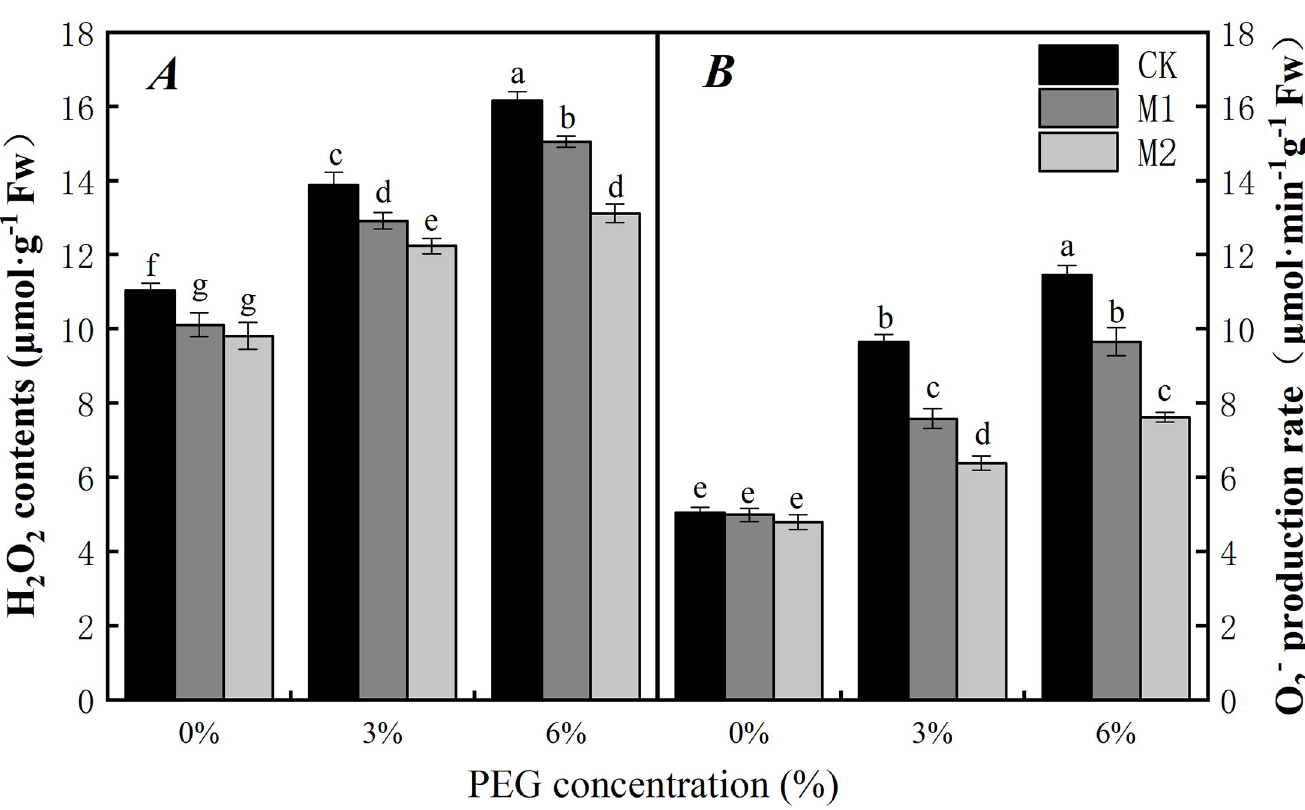
Fig 2. Effect of soaking with melatonin on H 2 O 2 (A) contents and O2 � − (B) production rate of soybean radicle under PEG stress. 0%, 3% and 6% were indicated 0%, 3% and 6% PEG6000 ( w/v ). Values are the means of three replicates ± S.E. Bars with different letters are significantly different at P � 0.05.